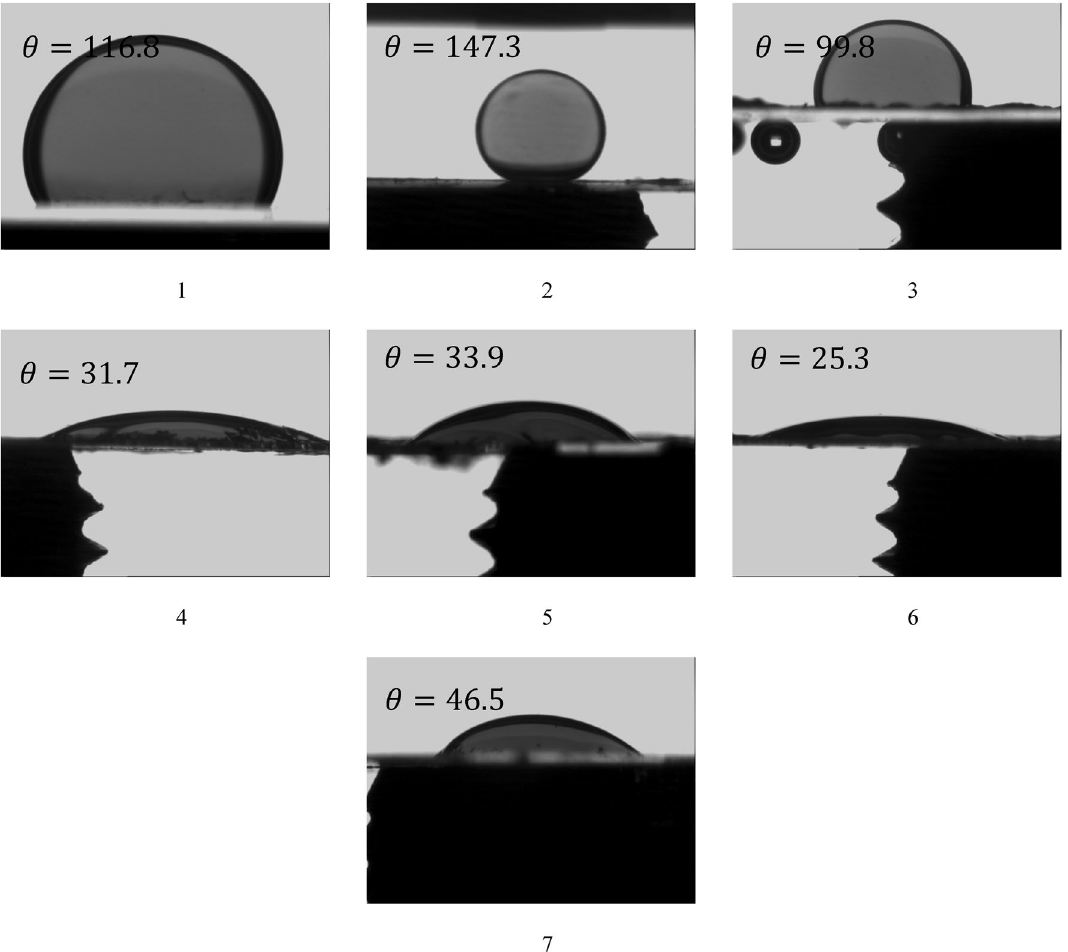
Fig. 10 Contact angle measurement for Ahwaz-Bangestan asphaltene samples in different